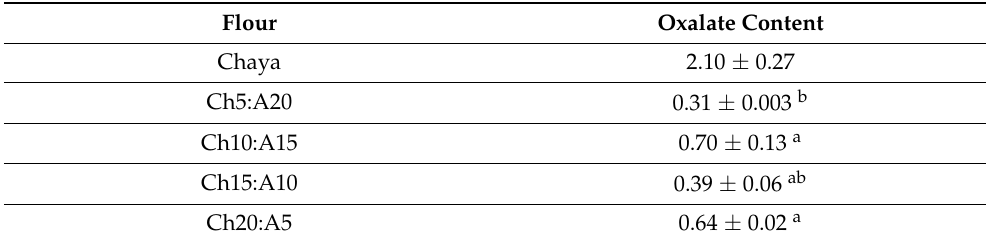
Values are mean ± SD. Statistical differences are indicated by different letters (a > b). Value of p < 0.05 is considered significant. Ch5:A20: 40 g of wheat flour + 5 g of chaya flour + 20 g of amaranth flour; Ch10:A15: 40 g of wheat flour + 10 g of chaya flour + 15 g of amaranth flour; Ch15:A10: 40 g of wheat flour + 15 g of chaya flour + 10 g of amaranth flour; and Ch20:A5: 40 g of wheat flour + 20 g of chaya flour + 5 g of amaranth flour.